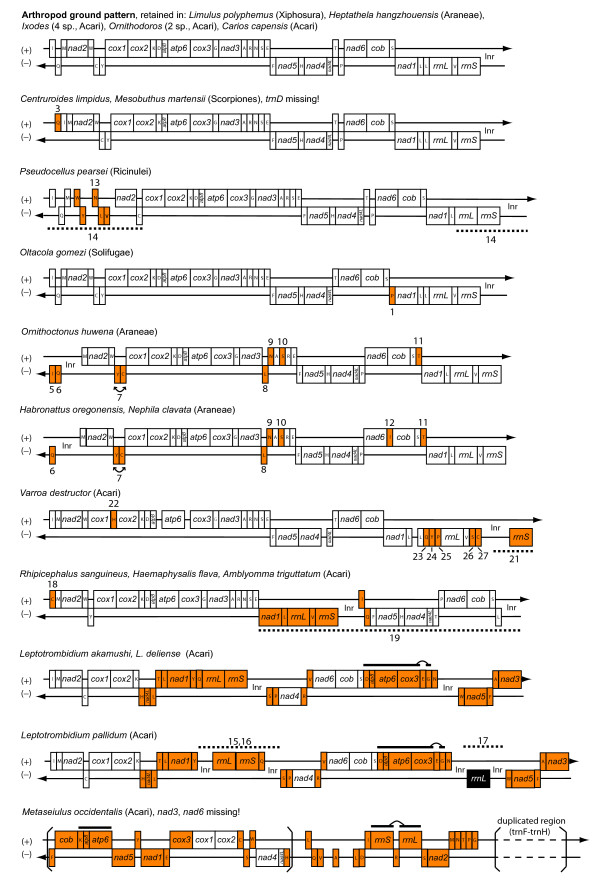
Changes in gene order in mitochondrial genomes of Arachnida compared to the putative ancestral arthropod gene order. Transfer RNA genes are labelled according to the one letter amino acid code. Genes marked white show the same relative position as in the arthropod ground pattern; genes marked orange have relative positions differing from the arthropod ground pattern; the gene marked black indicates a duplicated rrnL gene in Leptotrombidium pallidum. Horizontal lines above genes illustrate adjacent genes which were probably translocated together; dotted lines indicate regions where tandem duplication and random deletion events may have occurred; connected arrows show adjacent genes which have switched their position, making it difficult to assess which gene was translocated. Braces accentuate the duplicated regions in the mitochondrial genome of Metaseiulus occidentalis. lnr: large non-coding region, putative mitochondrial control region; other non-coding regions (> 50 bp) are illustrated by gaps between genes. Numbers refer to rearrangement events, compare Fig. 6. For GenBank accession numbers see Table 2.